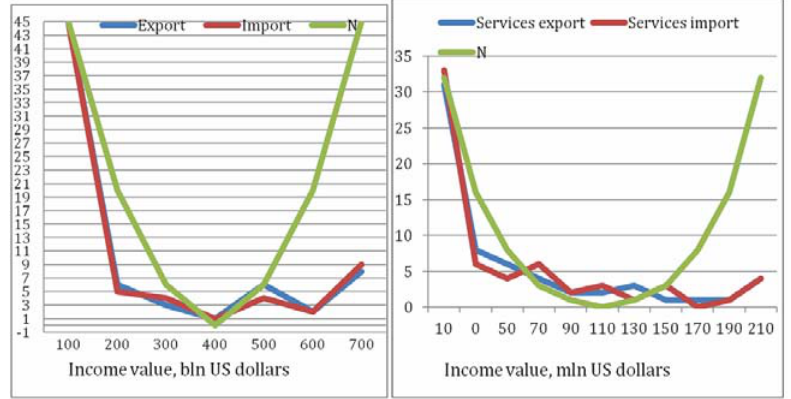
Fig. 1. Indicators of the level of economic processes asymmetry on the international scale